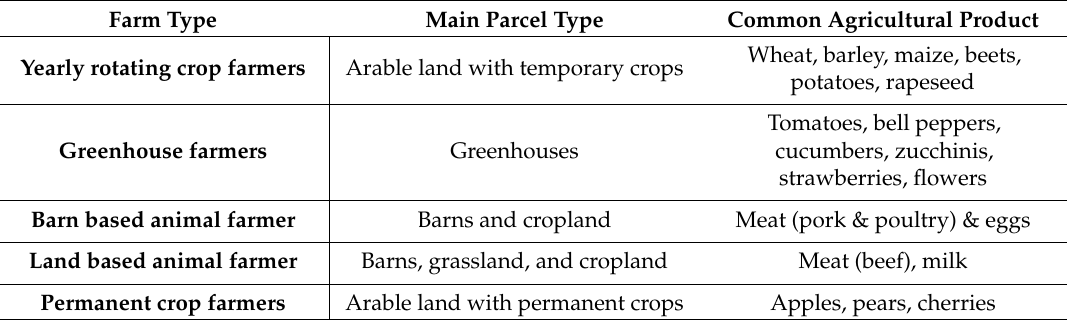
Table 2. Characteristics of different farm